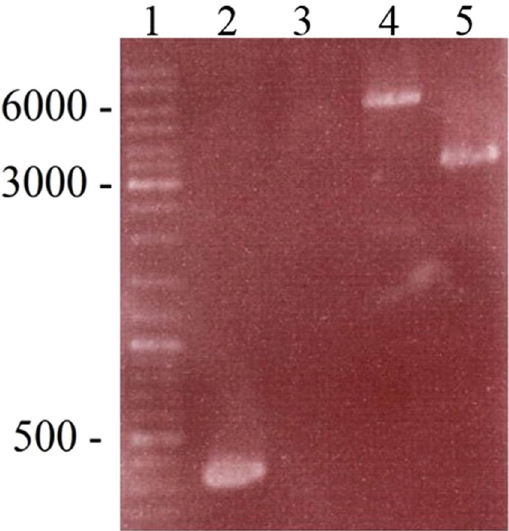
Figure 1. PCR analysis on the gerBAC region of the parental strain NCTC 11219 Δ bont Δ pyr and the Δ bon t Δ pyr ∆ gerBAC mutant. Lane 1: Molecular size marker (GeneRuler from Thermo Scientific); Lane 2: Parental strain, internal fragment of gerA amplified with primers gerA_F and gerA_R (expected size: 329 bp). Lane 3: ∆ gerBAC , no internal gerA fragment could be amplified with primers gerA_F and gerA_R. Lane 4: Parental strain, gerBAC locus amplified with primers ∆ gerBAC_upF and ∆ gerBAC_downR (expected size: 6252 bp). Lane 5: ∆ gerBAC, gerBAC locus amplified with primers ∆ gerBAC_upF and ∆ gerBAC_downR (expected size: 3198